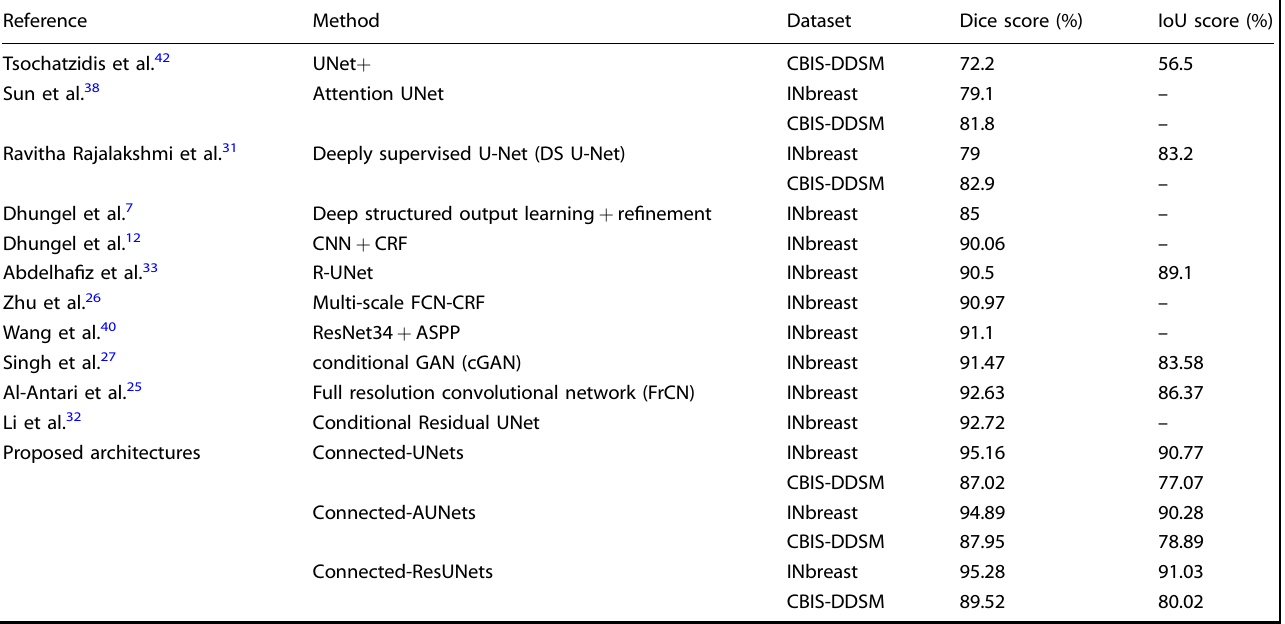
Table 5. Comparison of the proposed architectures and state-of-the-art